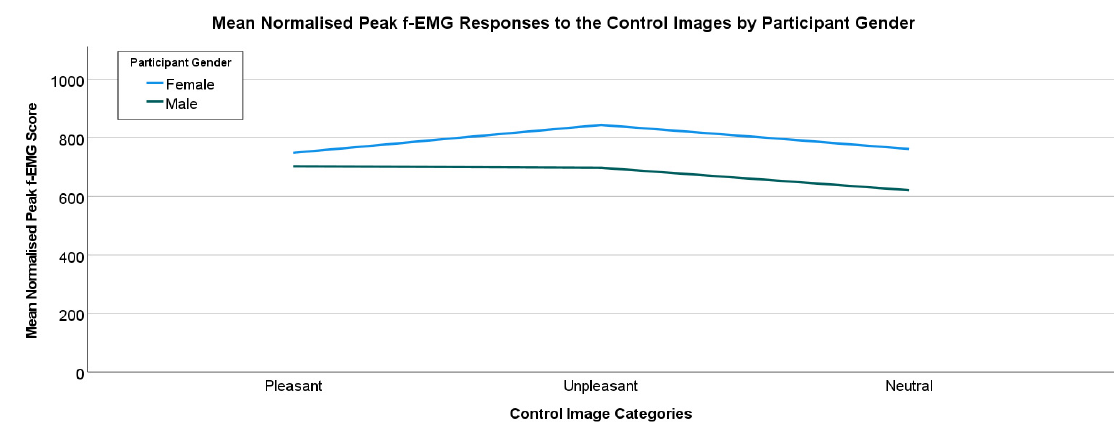
Figure 7. Responses to the Control imagery by participants’ self-reported bio sex.